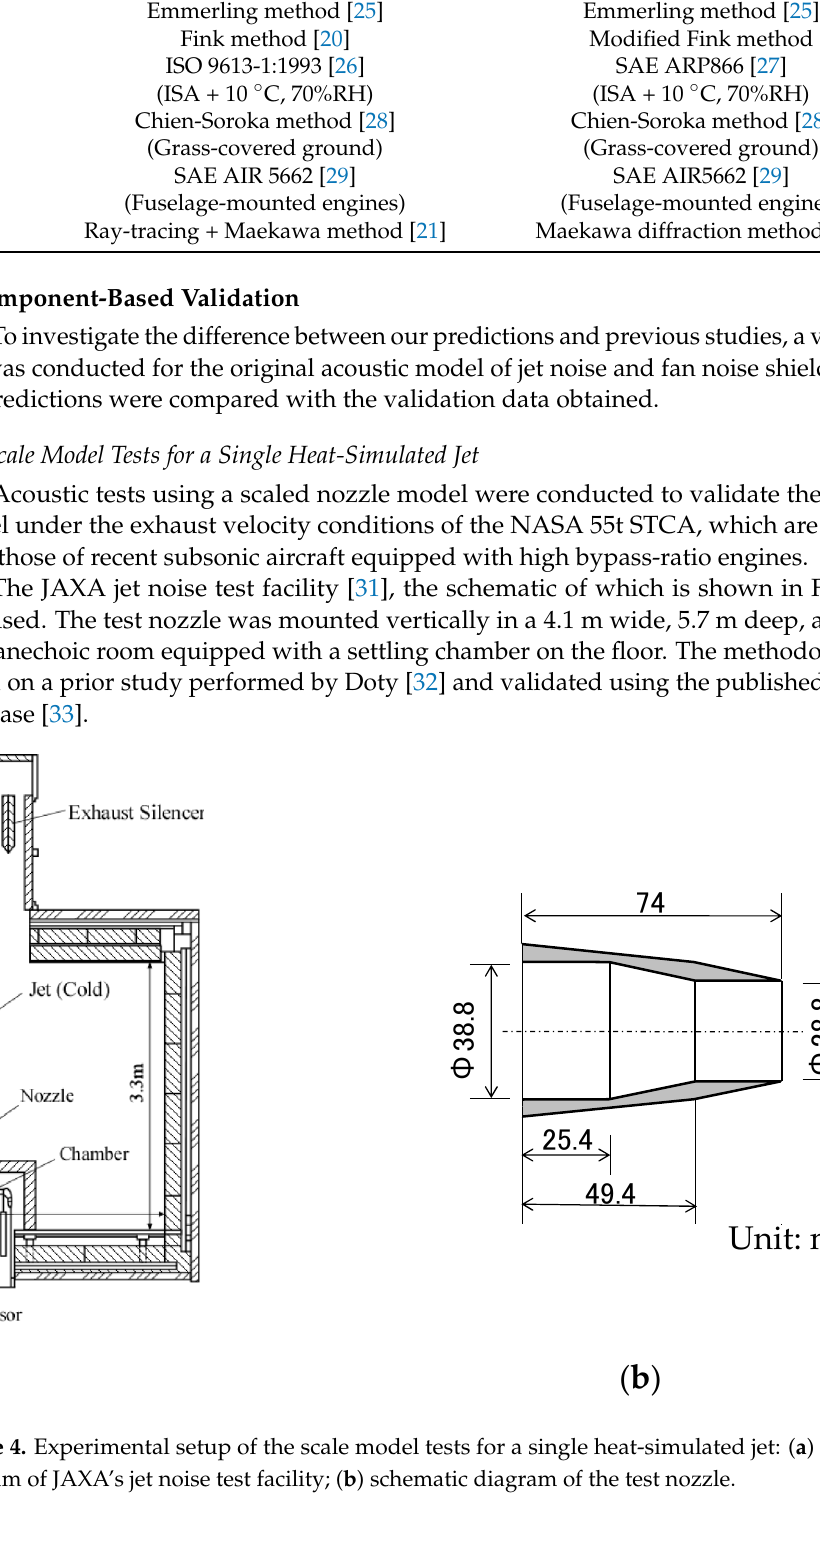
( b ) Figure 5. Comparison between the predicted and measured SPLs for a single heat-simulated jet operated at the jet velocity of 392.8 m/s and the jet total temperature ratio of 1.75: ( a ) θ = 90°, ( b ) θ = 150°. 3.2. Ground Noise Measurement Tests Using JAXA’s Experimental Aircraft Ground noise measurement tests using a JAXA experimental aircraft (Hisho [37]) were conducted at Nagoya Airport Flight Research Center to validate the prediction of the jet noise generated by the engine, similar to that anticipated for use in the NASA 55t STCA. The original aircraft, a Cessna 680, was equipped with two PW306C engines on its rear fuselage. The engine was a two-spool mixed-flow turbofan. The bypass ratio under static sea-level conditions was 4.5. The layout of the aircraft and measurement system, and a photograph of the test site, are shown in Figure 6. The noise was measured using eight microphones arranged in an arc, which was 40 times the nozzle exit diameter from the nozzle exit of the left engine, at polar angles θ ranging from 90° to 160° at 10° intervals. The microphones used for the acoustic measurements were 1/4-inch pressure-field microphones (B&K4938-L-002 and GRAS40BD). The sampling frequency and time were 102.4 kHz and 20 s, respectively. A